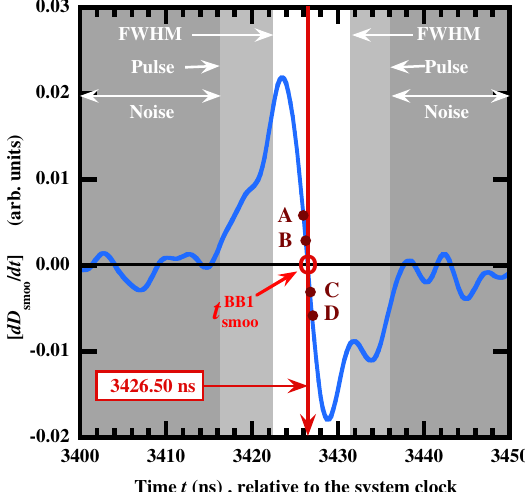
FIG. 10. The first derivative of D vs time. The peak time smoo t = dt ¼ 0 , is indicated. For reference, , taken where dD smoo smoo derivative values for adjacent time values are shown: (a) 3426.00 ns, (b) 3426.25 ns, (c) 3426.75 ns, and (d) 3427.00.